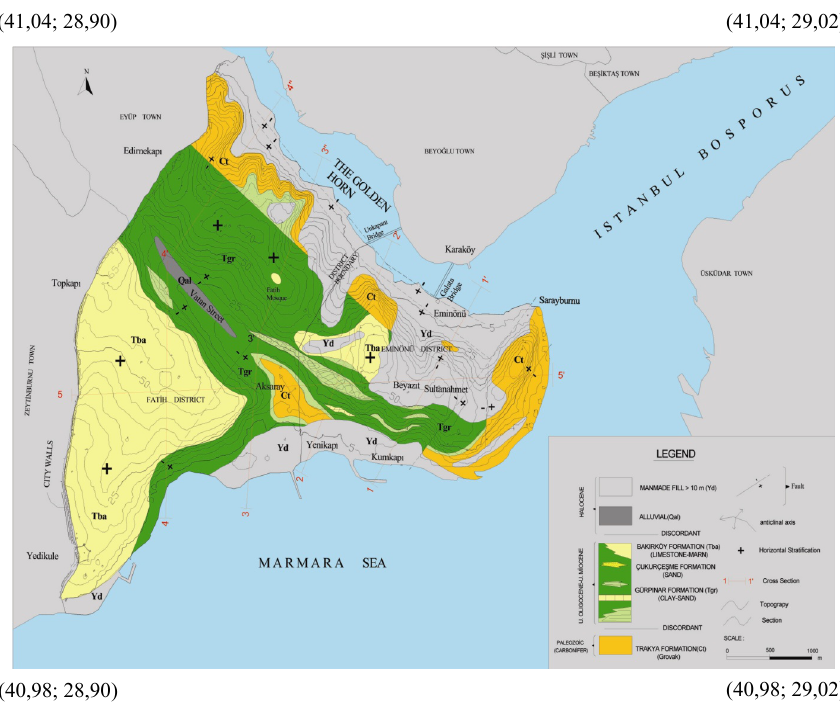
Figure 1. Geological map containing the five cross sections used in the analysis (˙Ince et al,